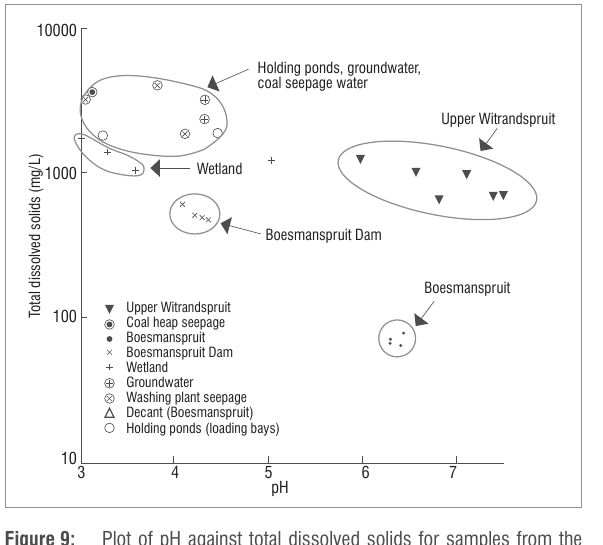
Plot of pH against total dissolved solids for samples from the Boesmanspruit catchment.